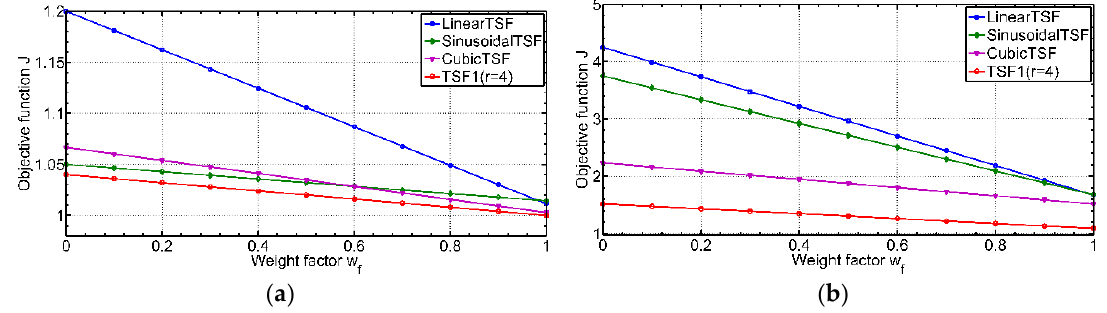
Figure 14. The values of the objective function J at different weight factors w f : ( a ) 1000 rpm; ( b ) 3000 rpm.